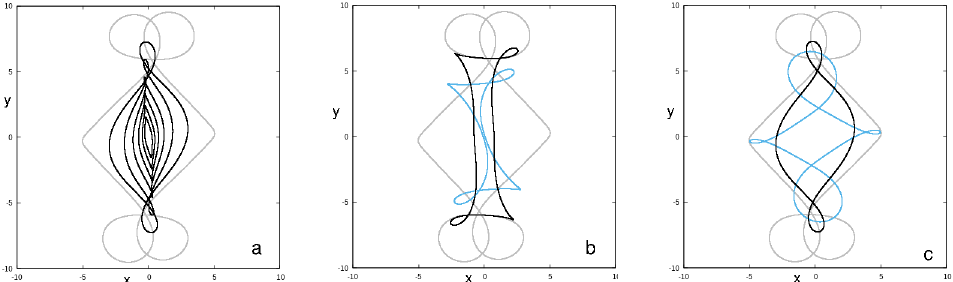
Figure 4. Periodic orbits with loops. ( a ) Stable orbits of x1 are plotted with black and an unstable f with pairs of loops at its apocenters is plotted with grey. ( b ) Two stable f orbits (black and cyan) and an unstable in grey. ( c ) POs with loops beyond the 4:1 resonance. The grey belongs to f, while the two others (black and cyan) to